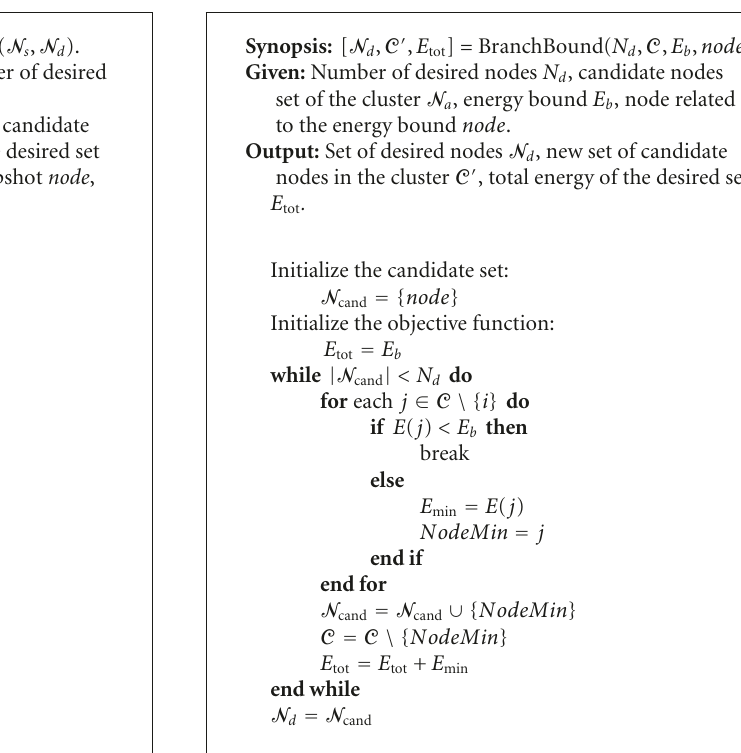
Algorithm 2: Branch and bound